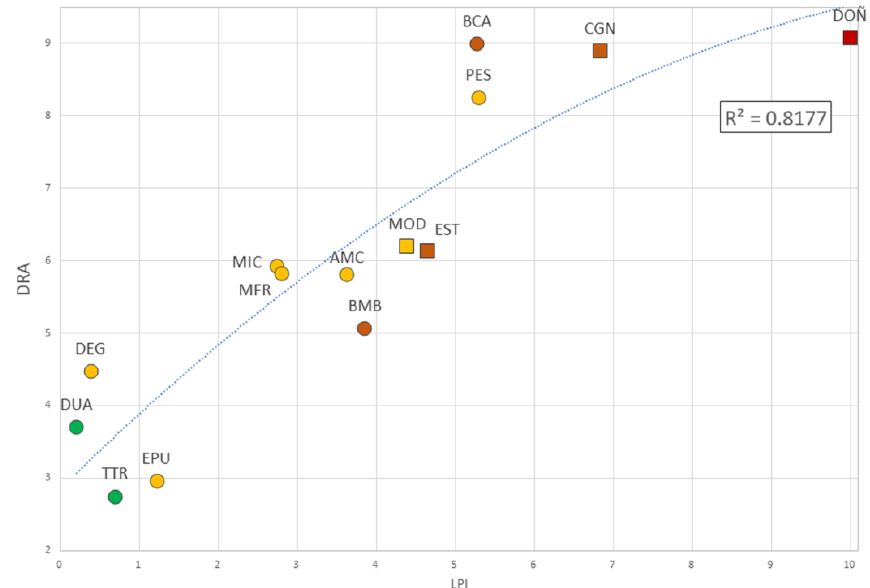
Figure 5. The Legal Protection Index [24] values compared to DRA. National Parks are shown in red, Natural Parks in orange, Natural Areas in yellow, and Natural Monuments in green. Protected Areas considered Biosphere Reserves are shown in squares.